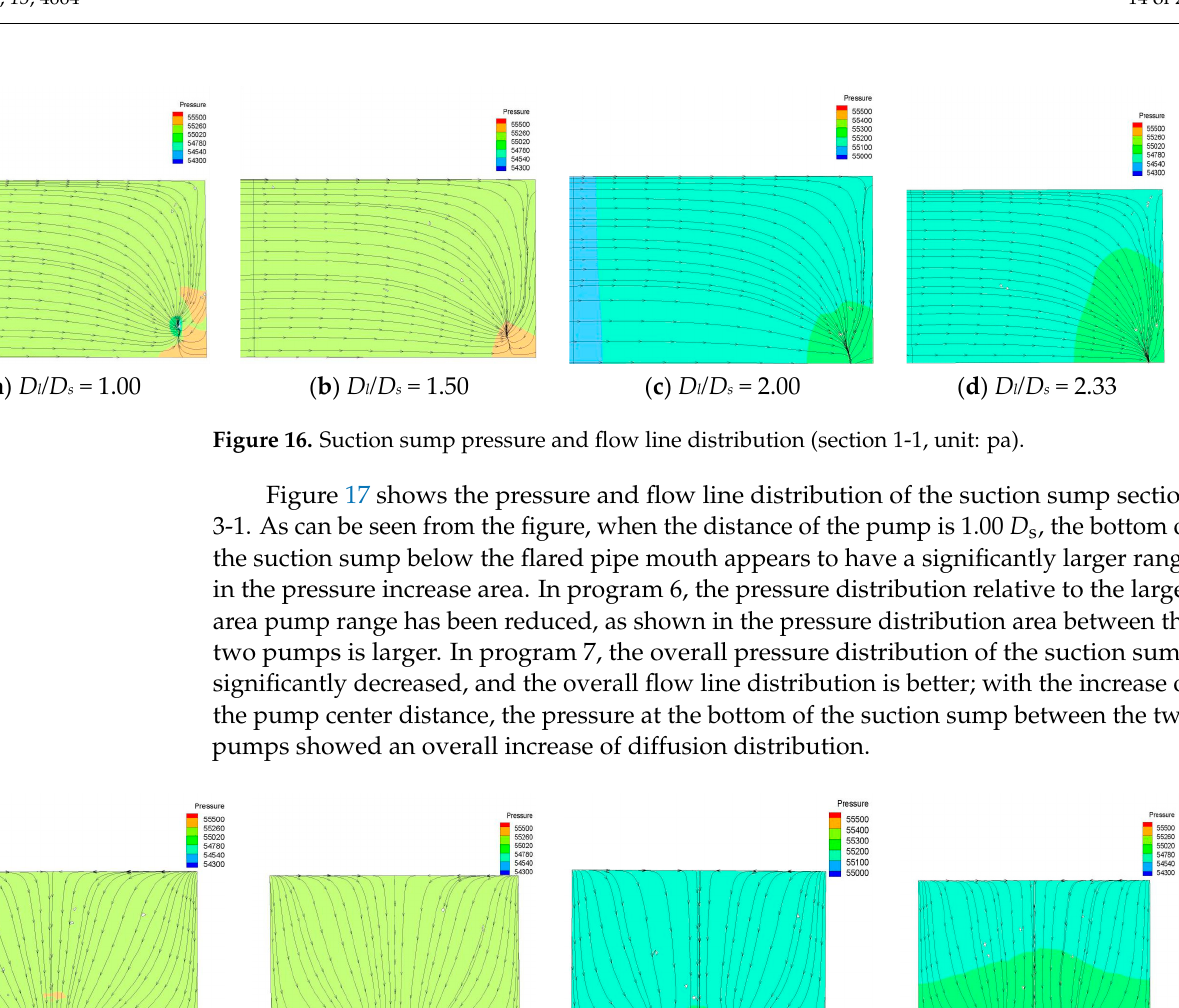
Figure 16. Suction sump pressure and flow line distribution (section 1 - 1, unit: pa).